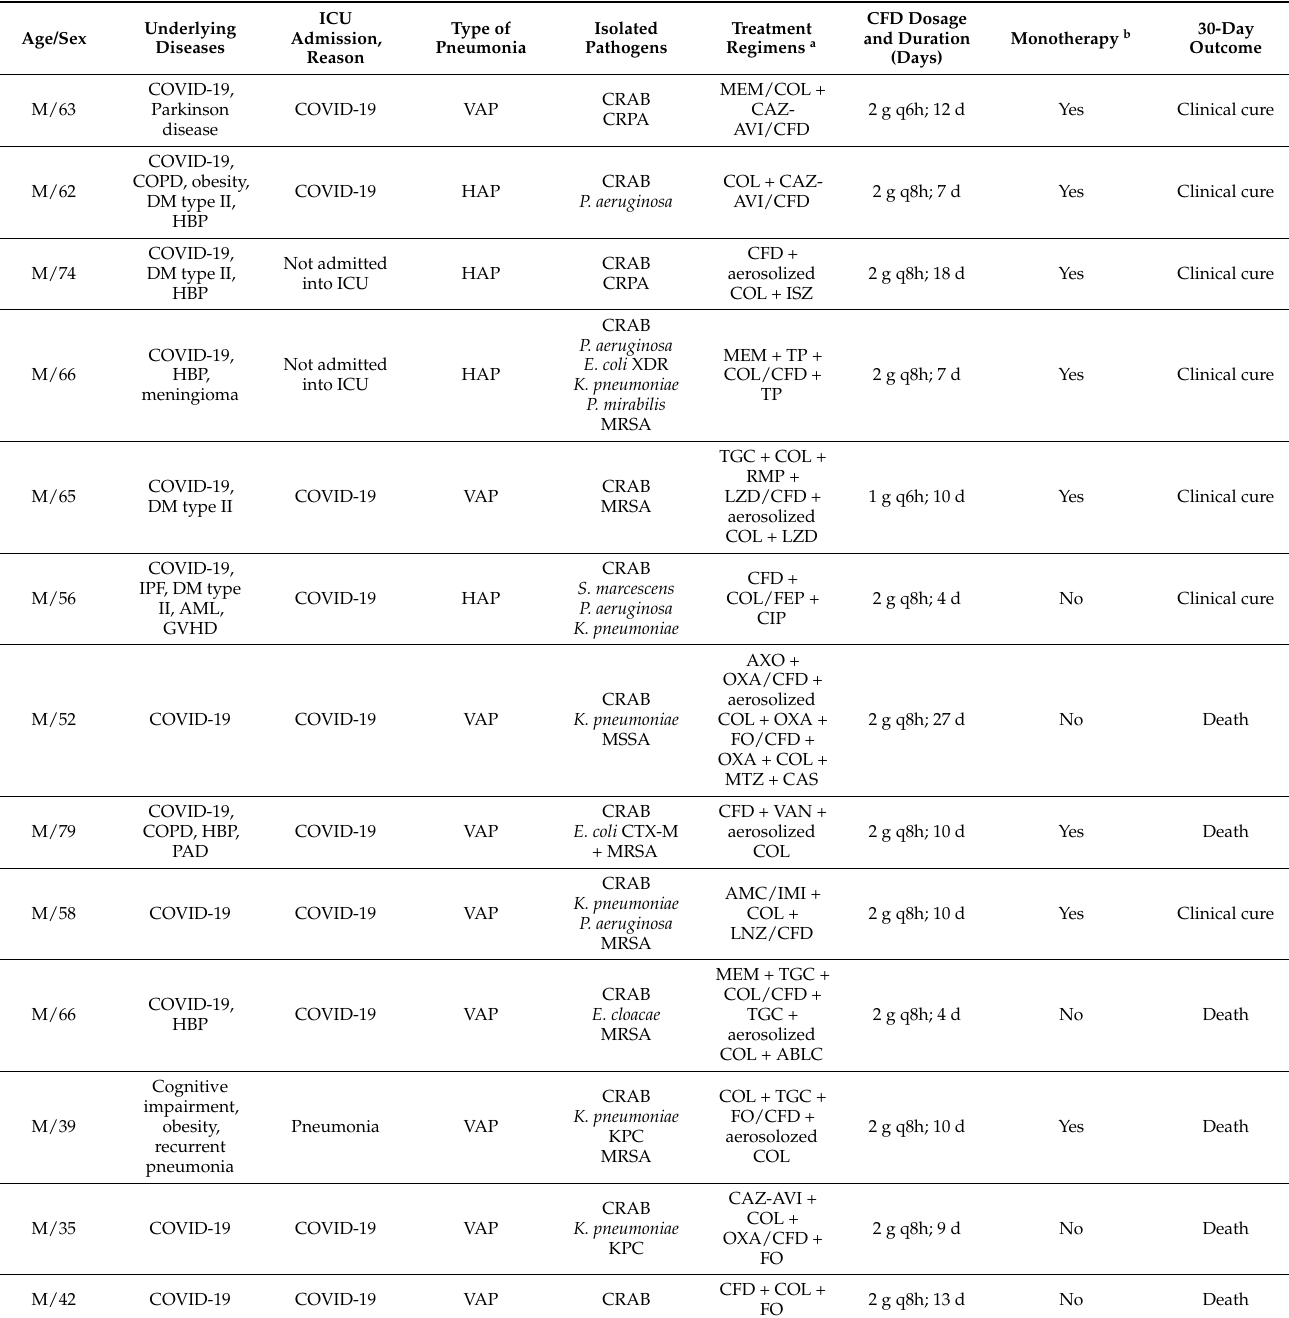
Table 1. Description of the 13 patients who developed HAP/VAP due to A. baumannii treated with